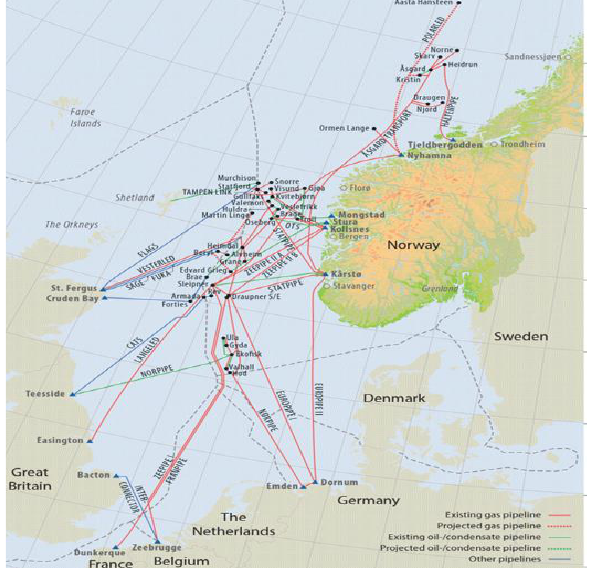
Figure 1. Pipelines from the North Sea (Norway) [21].